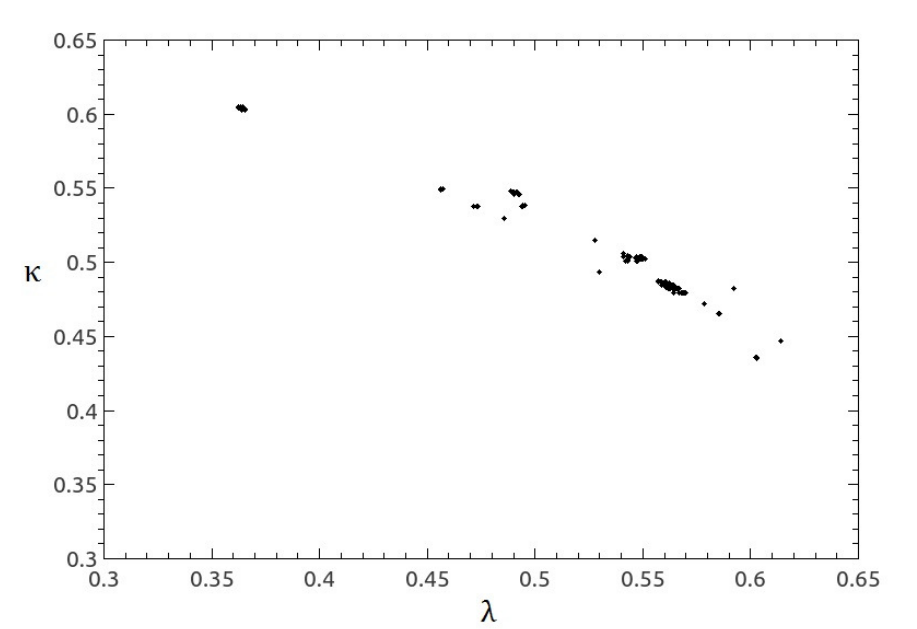
Figure 1 . The scattering plots of survived points for (cid:21) versus (cid:20) . All survived points satisfy the LHC and EW precision measurement constraints as well as the required value of (cid:1) a (cid:22)